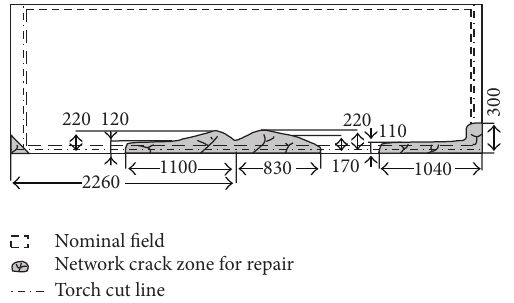
Figure 13: The clad plate made of carbon steel (34mm thick, grades 𝐸 𝑆 2 and 0 ) and duplex steel (6 mm thick) after ultrasonic testing (ASME SA 578), showing crack networks at edges and vertexes in the carbon steel plate.